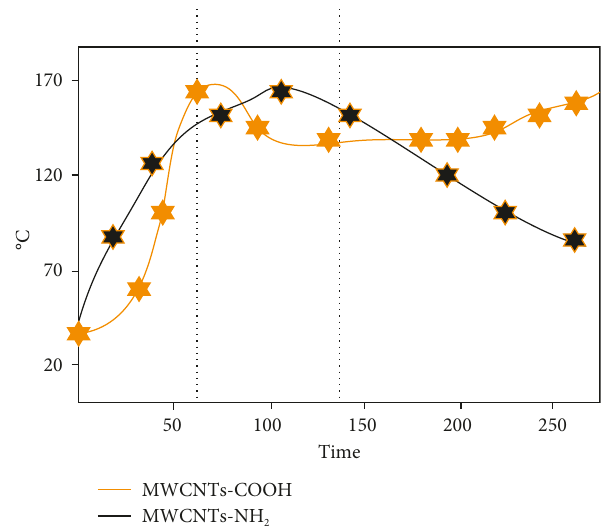
Figure 8: Curing process of composites over